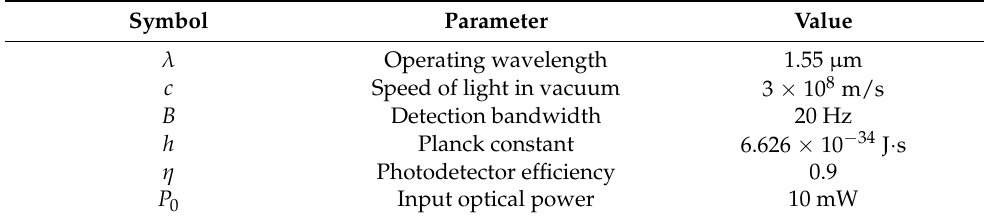
Table 2. Initial setting parameters setting.